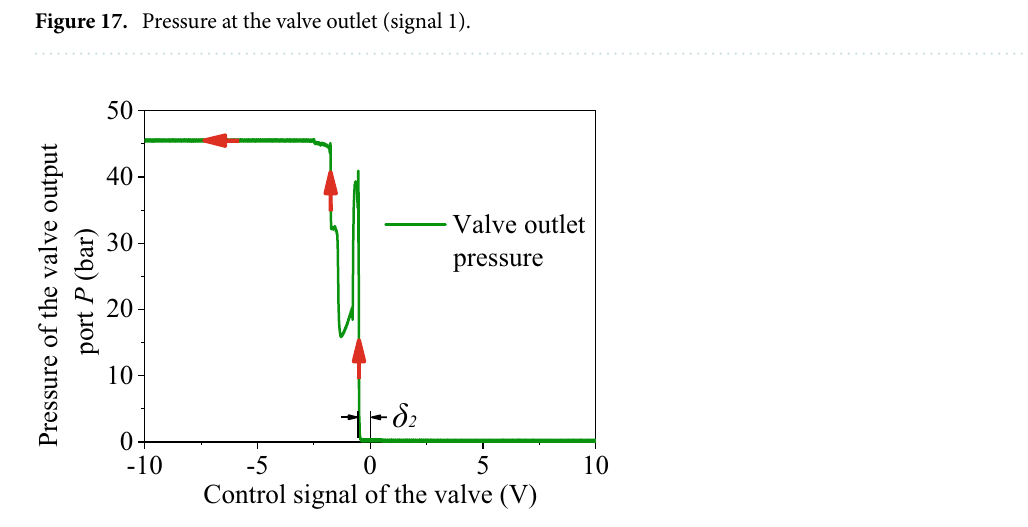
Figure 18. Pressure at the valve outlet (signal